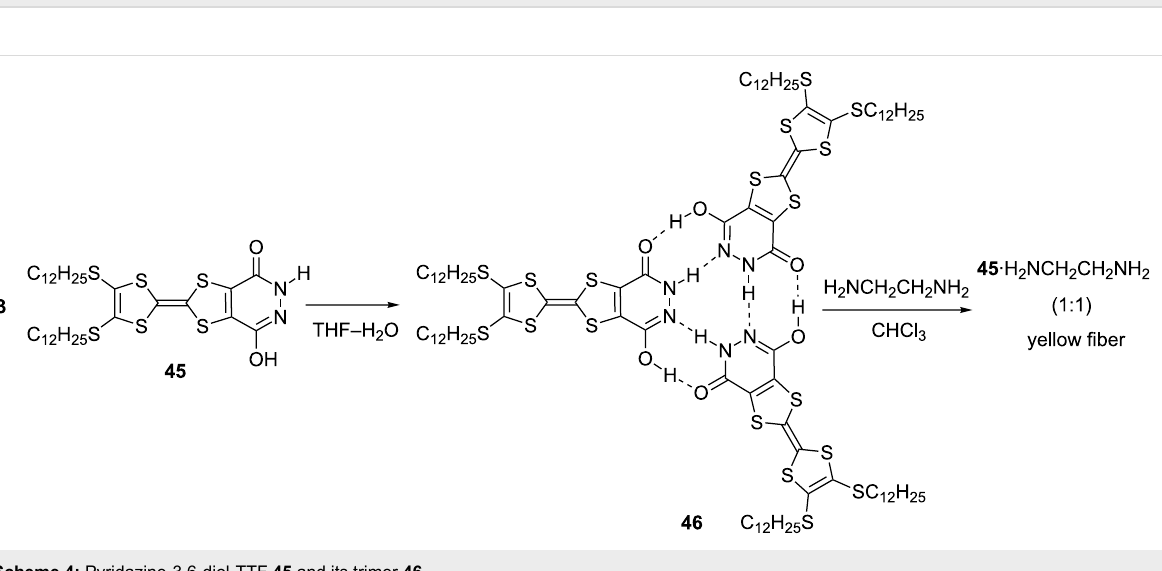
Figure 15: Stepwise oxidation of (a) 38 (0.02 mM), (b) 40 (0.05 mM), and (c) 42 (0.03 mM) with incremental addition of Fe(ClO 4 ) 3 in a mixture of CH 2 Cl 2 –CH 3 CN (2:1, v/v) at 25 °C. The blue line indicates the neutral absorption spectra, the green line the multiple TTF radical cations 38 3(•+) , 40 4(•+) , and 42 6(•+) , and the red line the TTF dications 38 6+ , 40 8+ , and 42 12+ . Adapted with permission from [23]. Copyright 2011 American Chemical